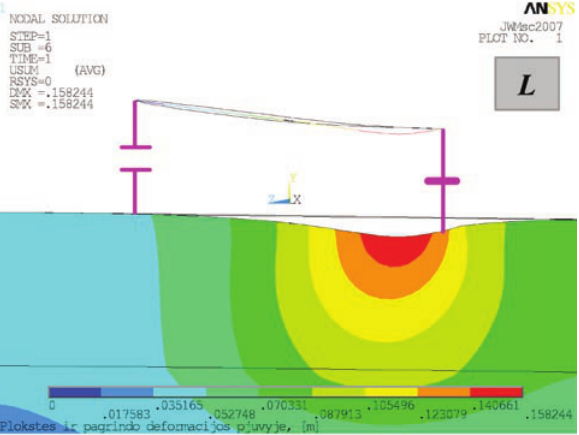
Fig. 11. Deflections of the plate and foundation in the section, m Fig. 11a. Deflections of the plate and foundation in the section, m